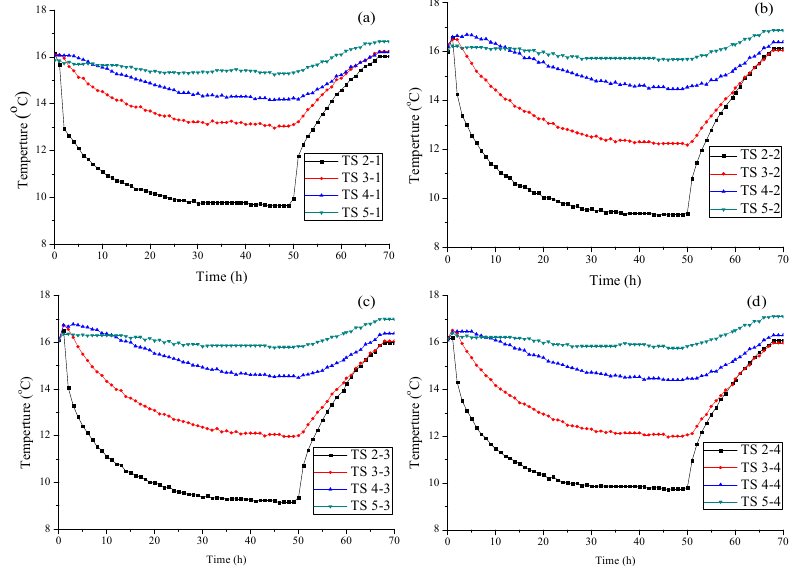
Figure 7. Time-dependent temperature curves of TSs of different distances to UT along each row in the fluid circulation of − 10 °C: ( a ) No.1 TSs; ( b ) No.2 TSs; ( c ) No.3 TSs; ( d ) No.4 TSs.